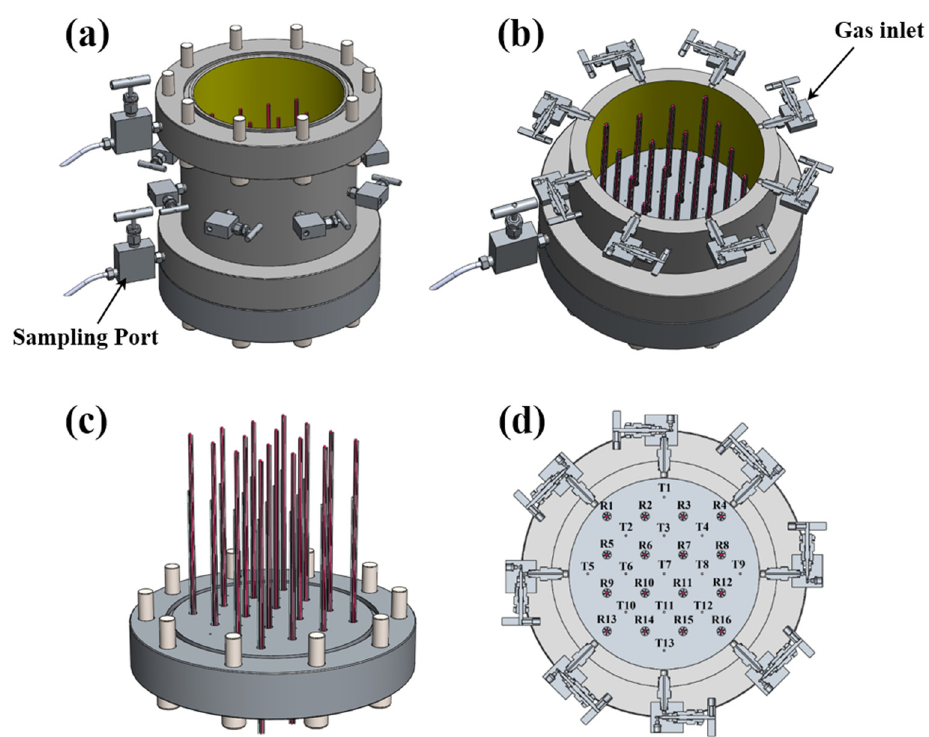
Figure 3. Detailed structure diagram of the LSC. ( a ) Overall structure, ( b ) cross-section of LSC body, ( c ) bottom plate, and ( d ) top view of temperature and electric resistance layout section.